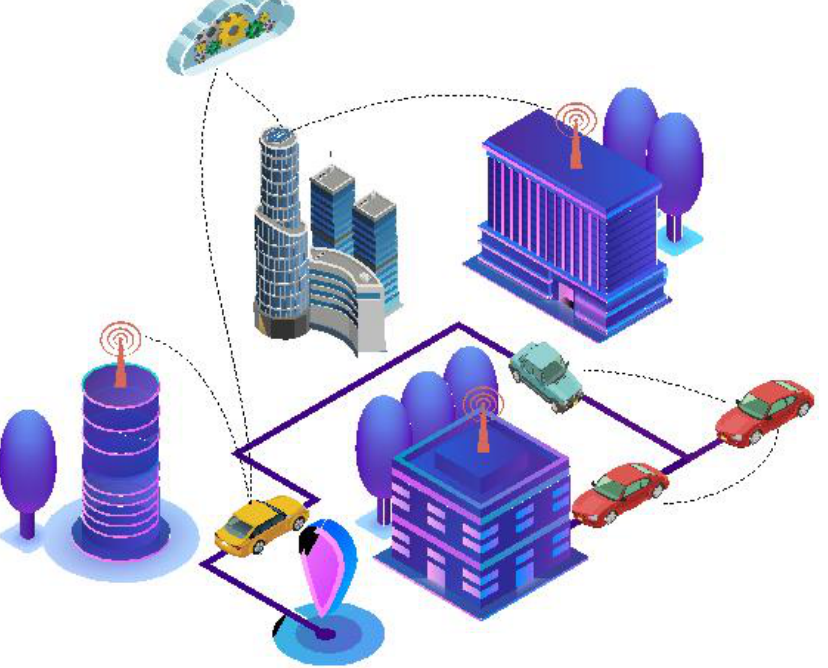
Figure 1. IoT sensors in a smart city for managing vehicle traffic.